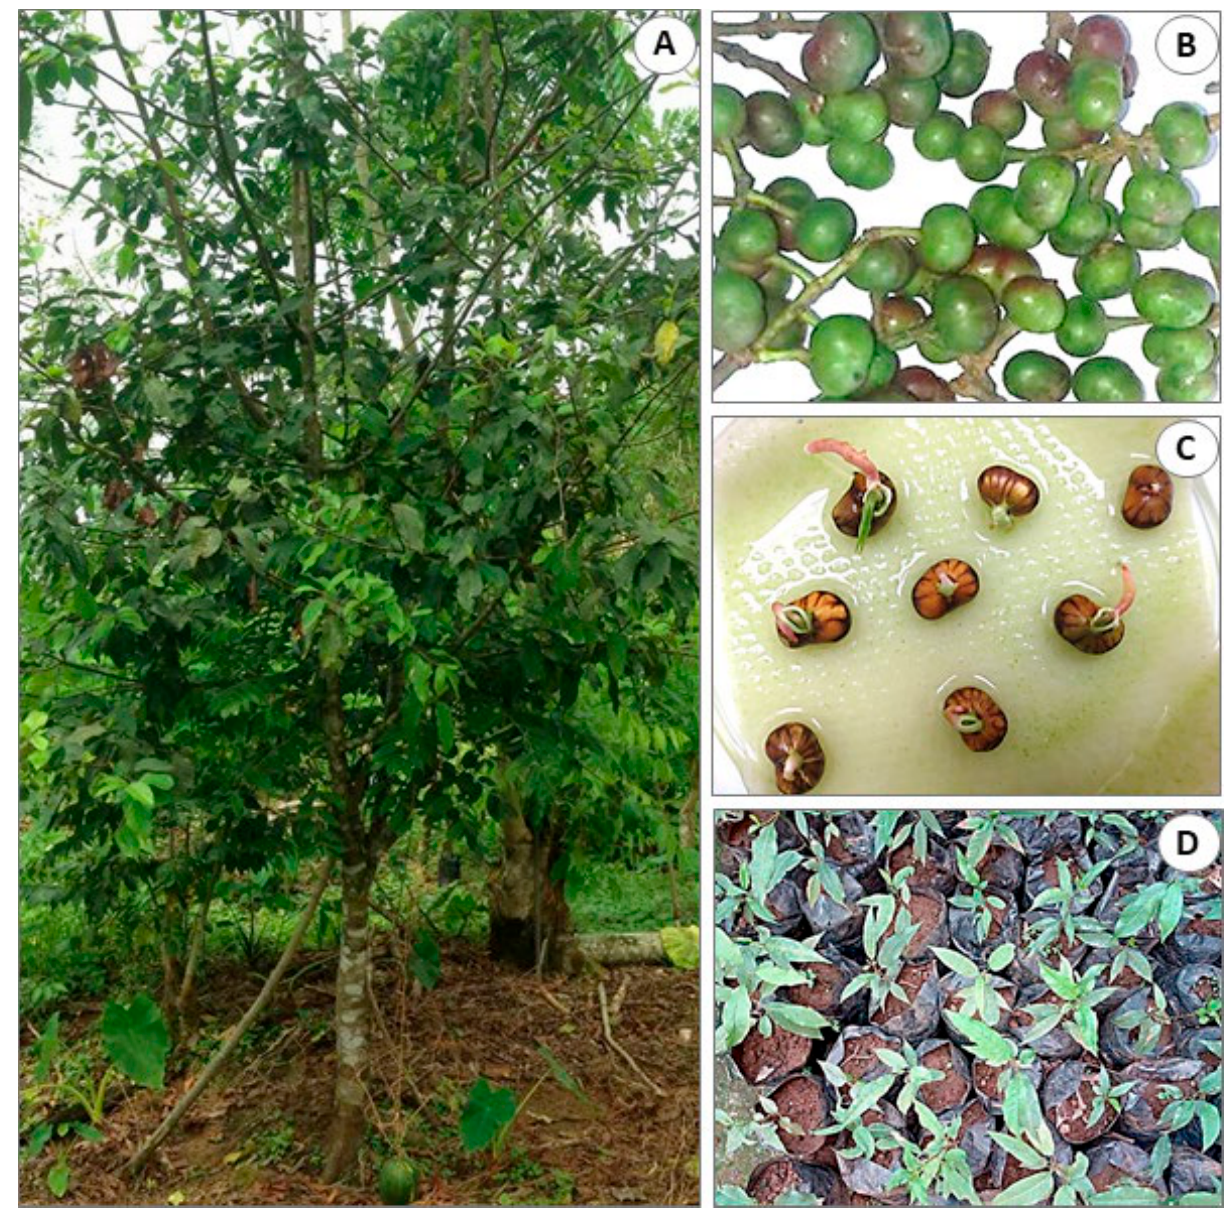
Fig. 2. Prunus africana: A) 6-years-old tree; B) fruit - two-lobed drupe, with a seed in each lobe; C) germination of seeds in Petri dishes; D)